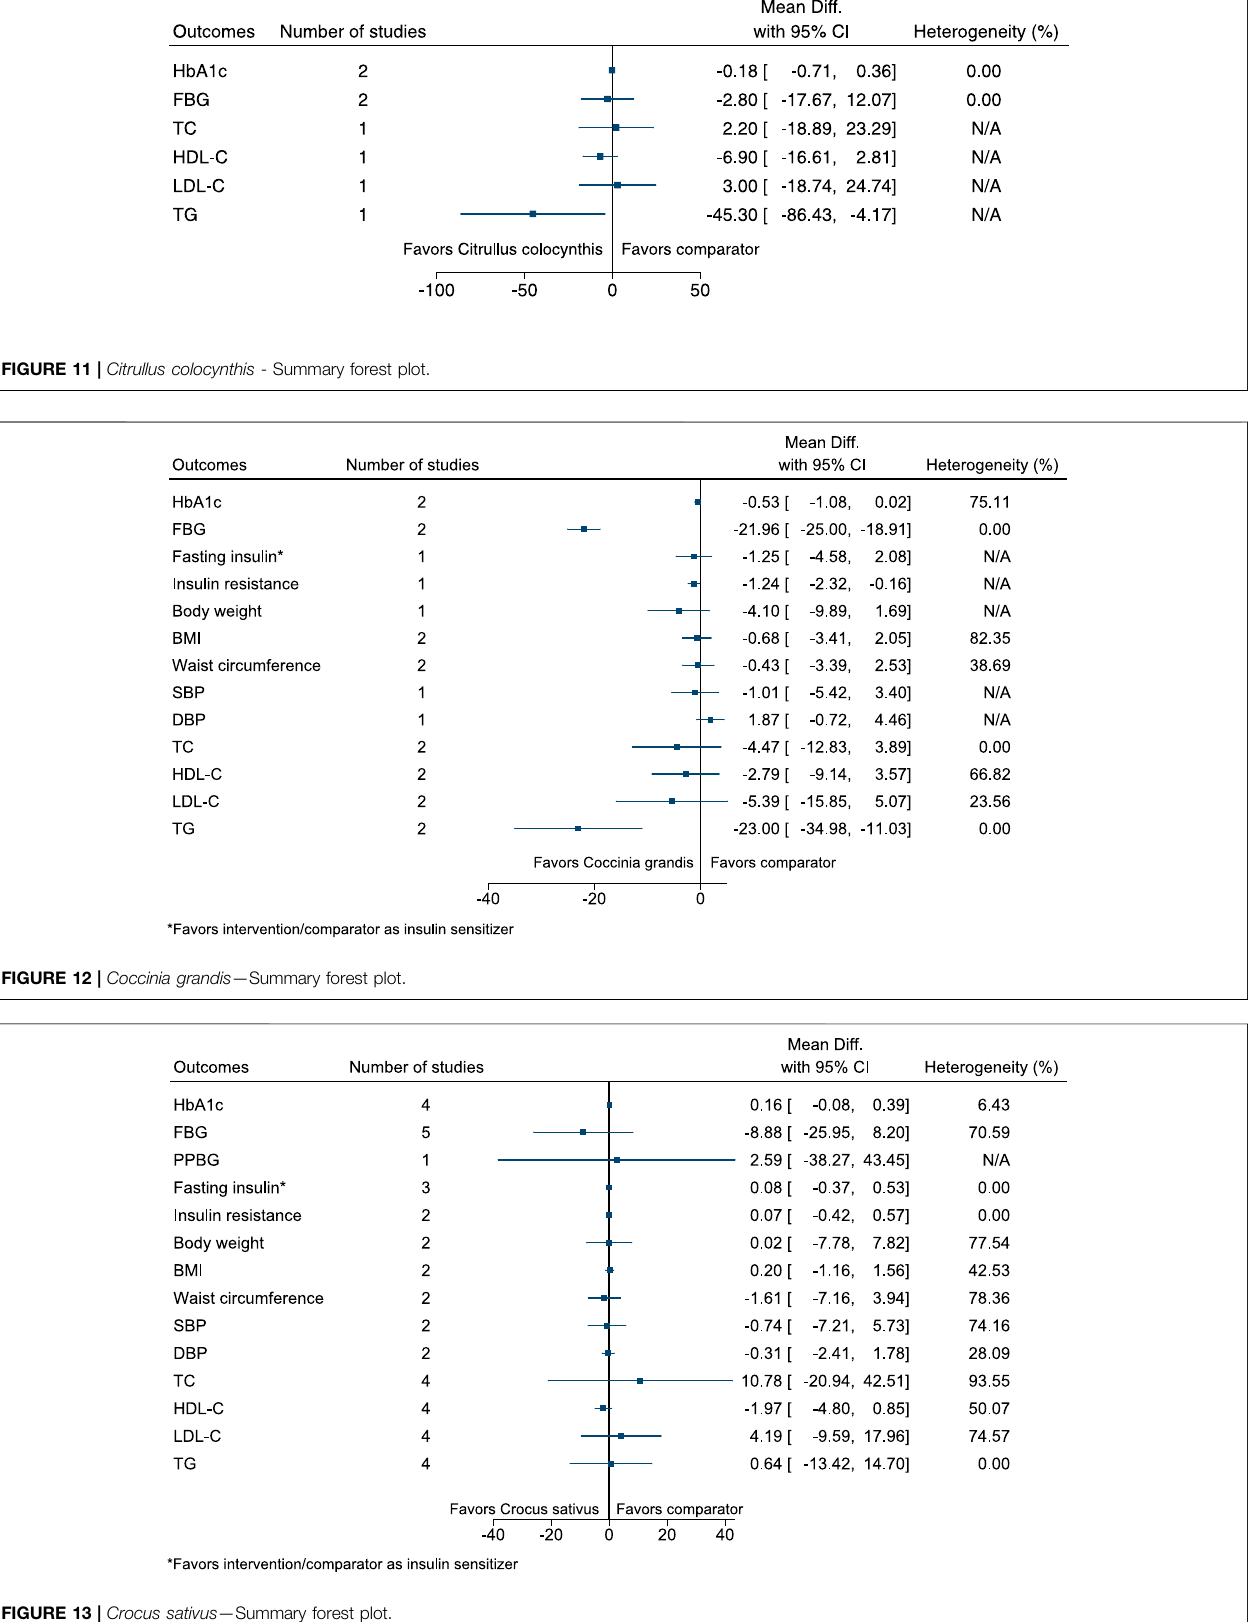
FIGURE 13 | Crocus sativus — Summary forest plot. Frontiers in Pharmacology |